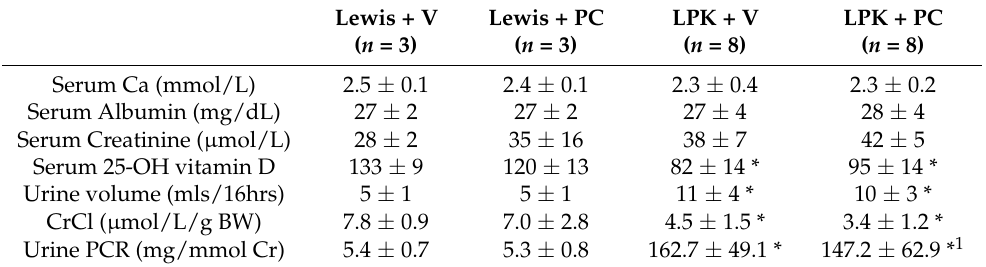
Table 1. Effect of early treatment with paricalcitol on renal function and disease progression at week 10.